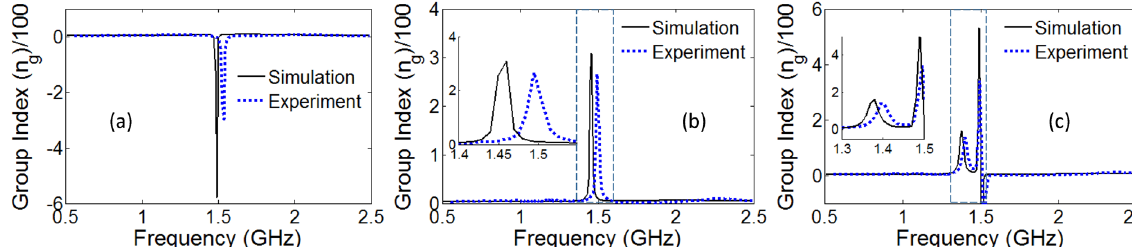
Figure 7. Retrieved values for effective group refractive index n g for the ( a ) single-stub, ( b ) double-stub resonator and ( c ) triple-stub resonator designs showing the Microwave buffer application of the open stub